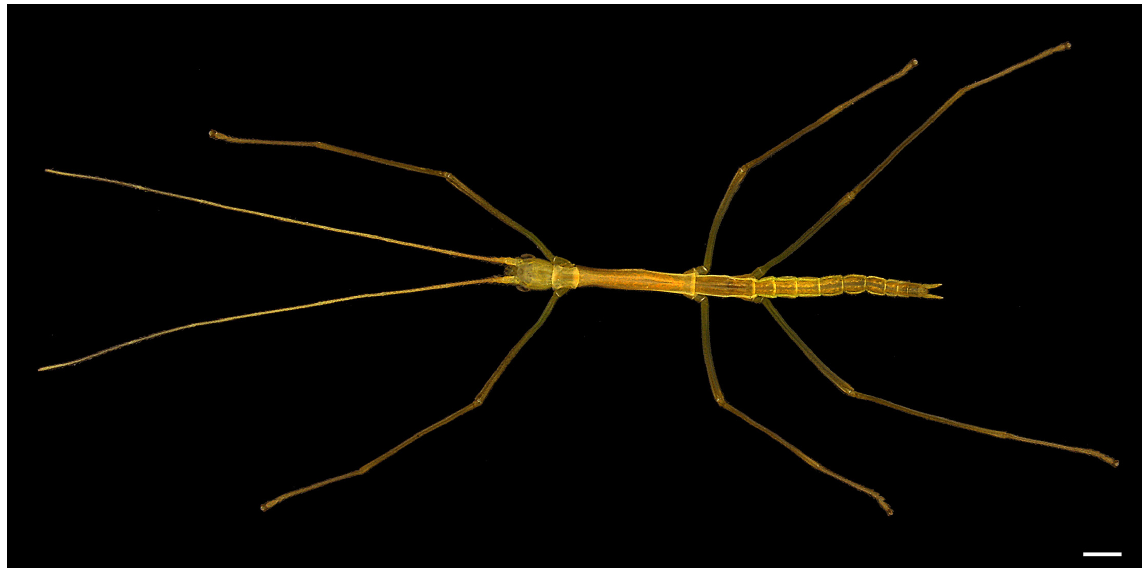
Fig. 9. Habitus of a recently deceased first instar female nymph of Arumatia dubia (Caudell, 1904) gen. et comb. nov. from stock from Ibaté, São Paulo, Brazil, in dorsal view. Scale bar: 1